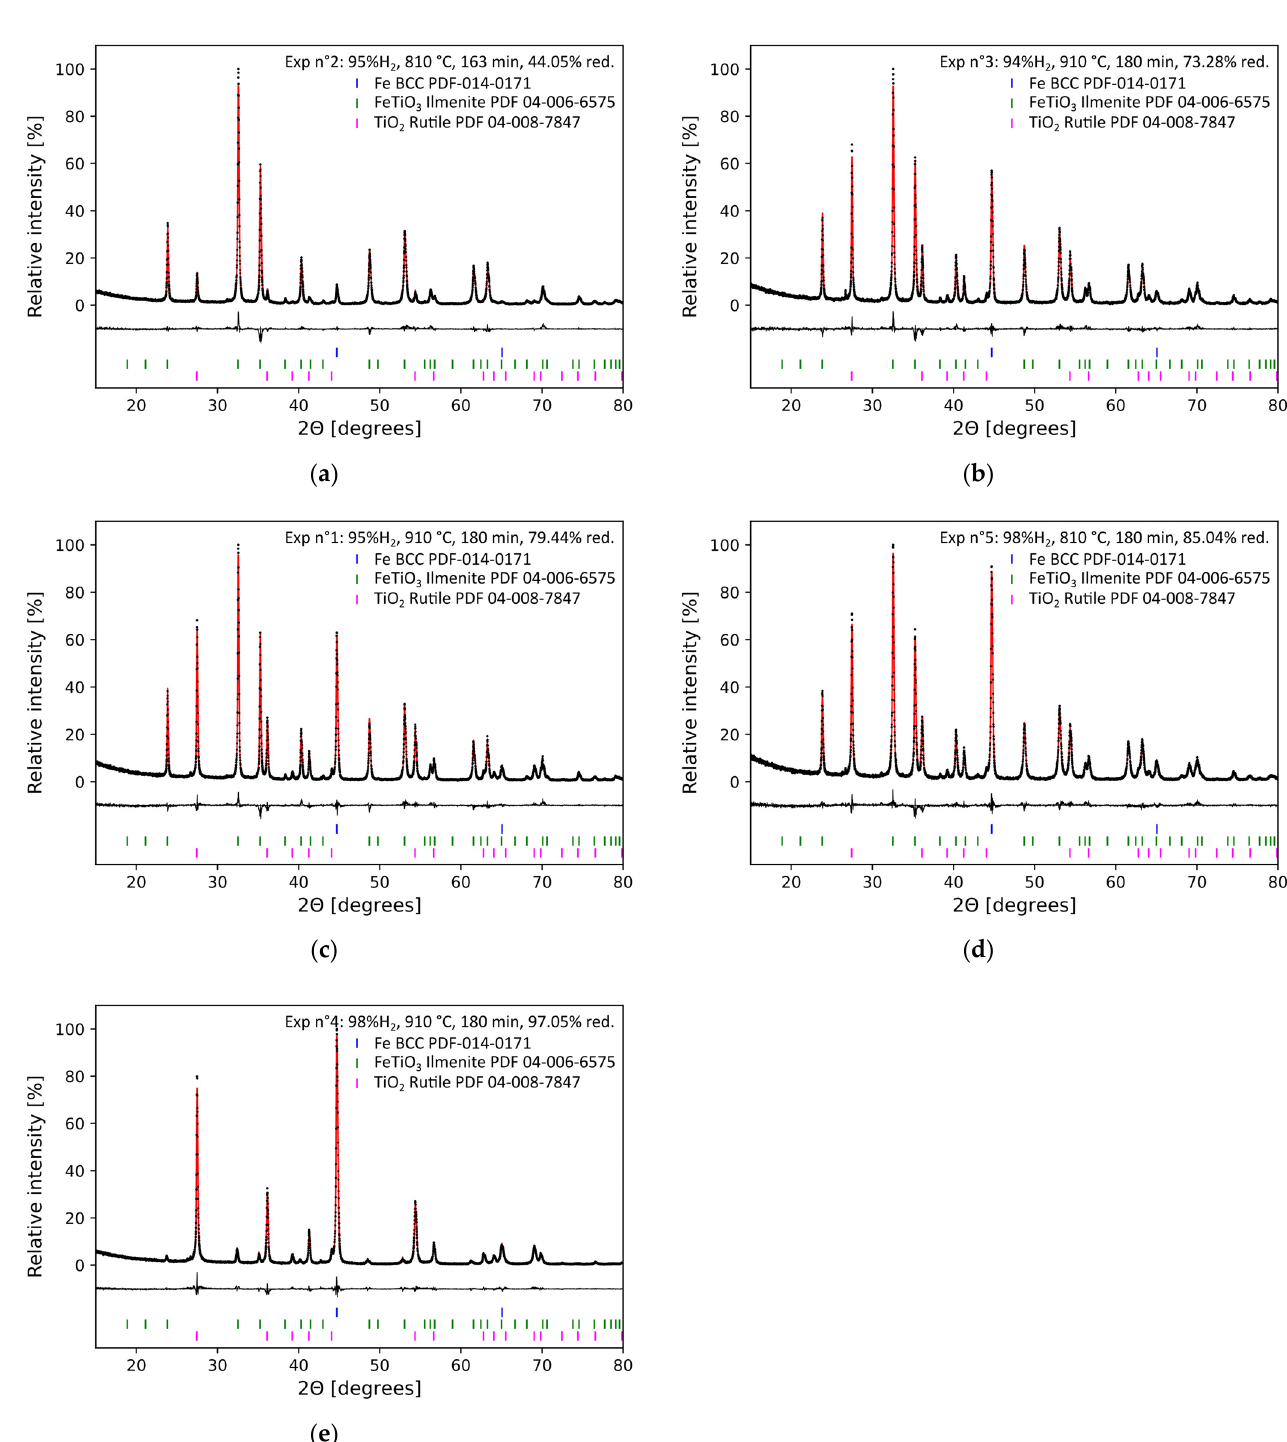
Figure 8. X-ray diffraction patterns for experiments 1–5. The graphs are presented from least to most reduced. The measured data are given as black dots and the fitted data are given as a red line. The difference between the fit and the measured pattern is plotted below the pattern. ( a ) Experiment at 810 ◦ C and 95%H 2 ; ( b ) experiment at 910 ◦ C and 94%H 2 ; ( c ) experiment at 910 ◦ C and 95%H 2 ; ( d ) experiment at 810 ◦ C and 98%H 2 ; ( e ) experiment at 910 ◦ C and 98%H 2